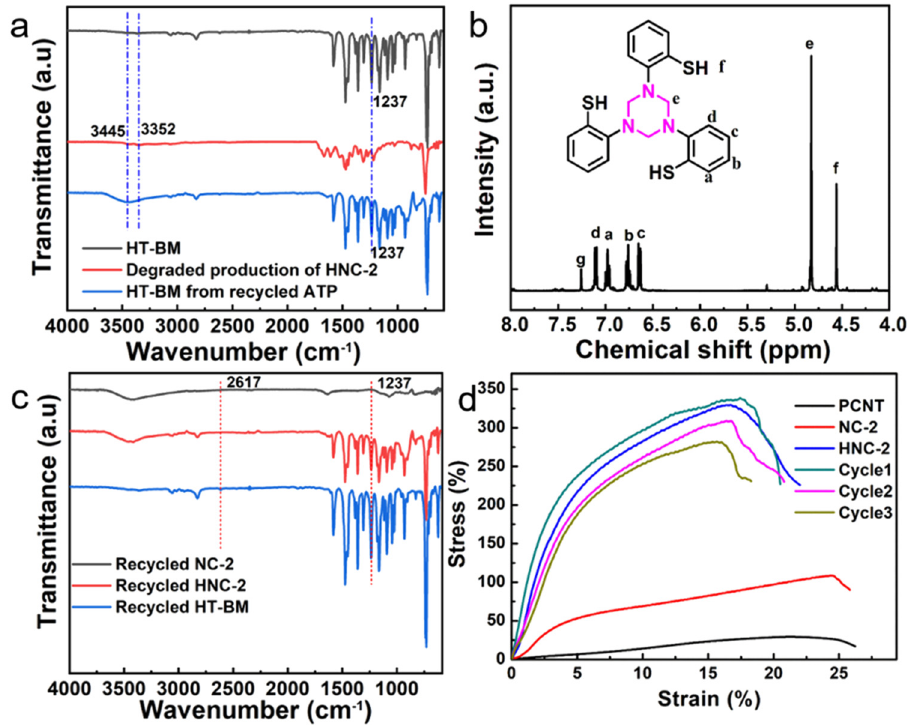
Figure 10: Properties of monomer and recovered thiol - functionalized CNT fi lm: ( a ) FT - IR spectra of a chemical compound, ( b ) 1 H - NMR of a chemical compound, ( c ) FT - IR spectra of modi fi ed CNT fi lm, and ( d ) stress – strain curves of recovered CNT fi